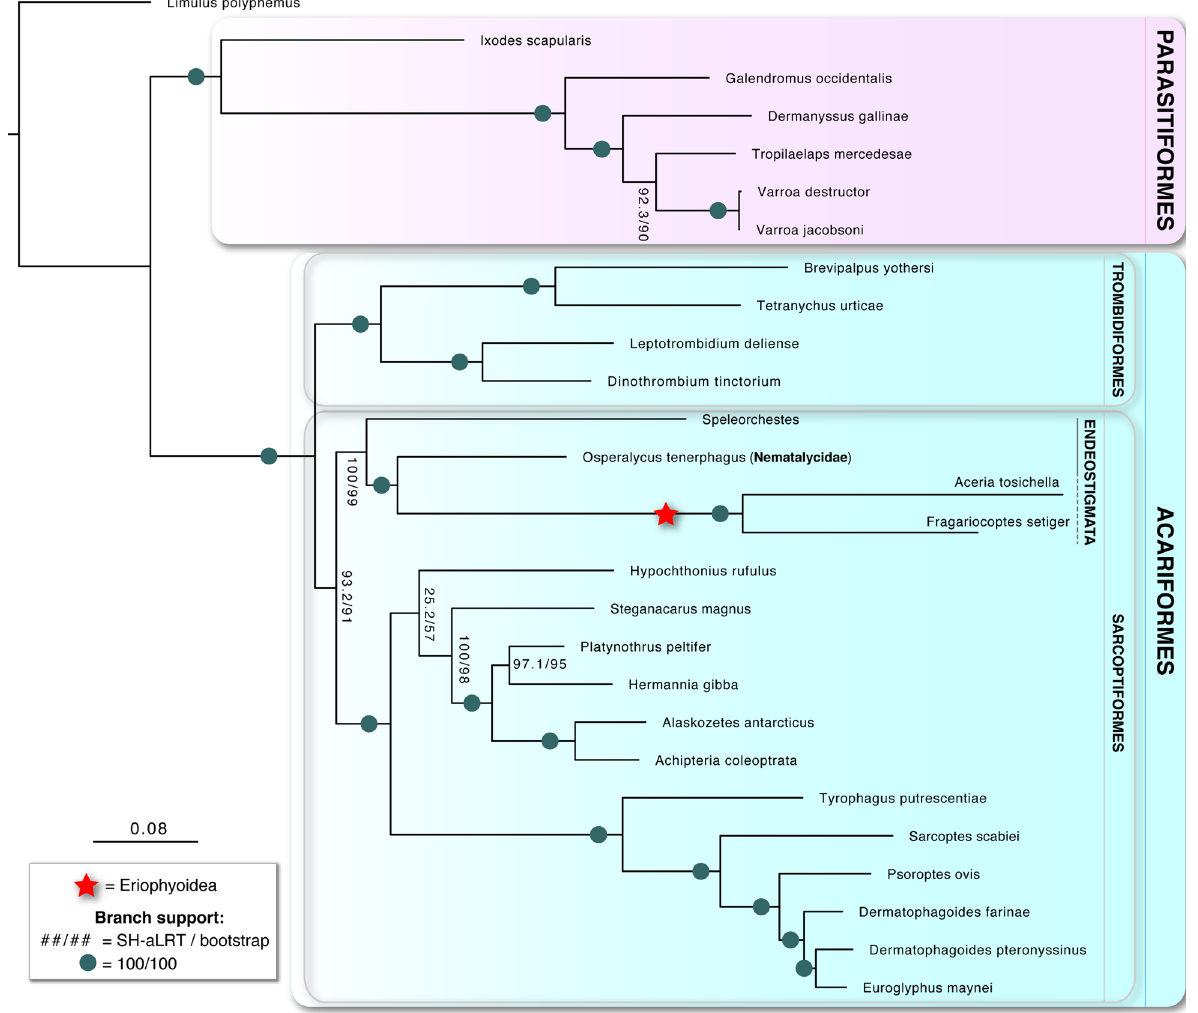
Figure 2. Relationships of parasitiform and acariform mites. Phylogenomic inference was undertaken using a Maximum likelihood framework in IQ-TREE based on 90 orthologous